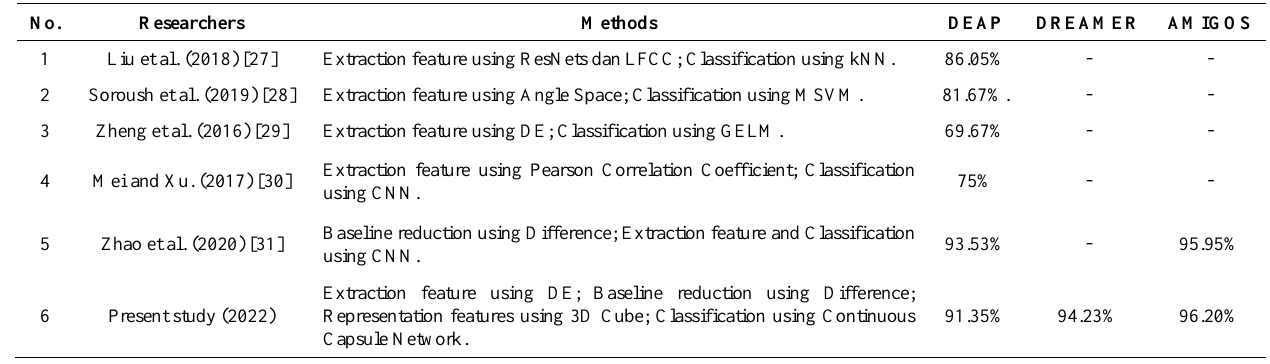
Table 10. Comparison of accuracy results between the proposed method and other methods for the four categories of emotions